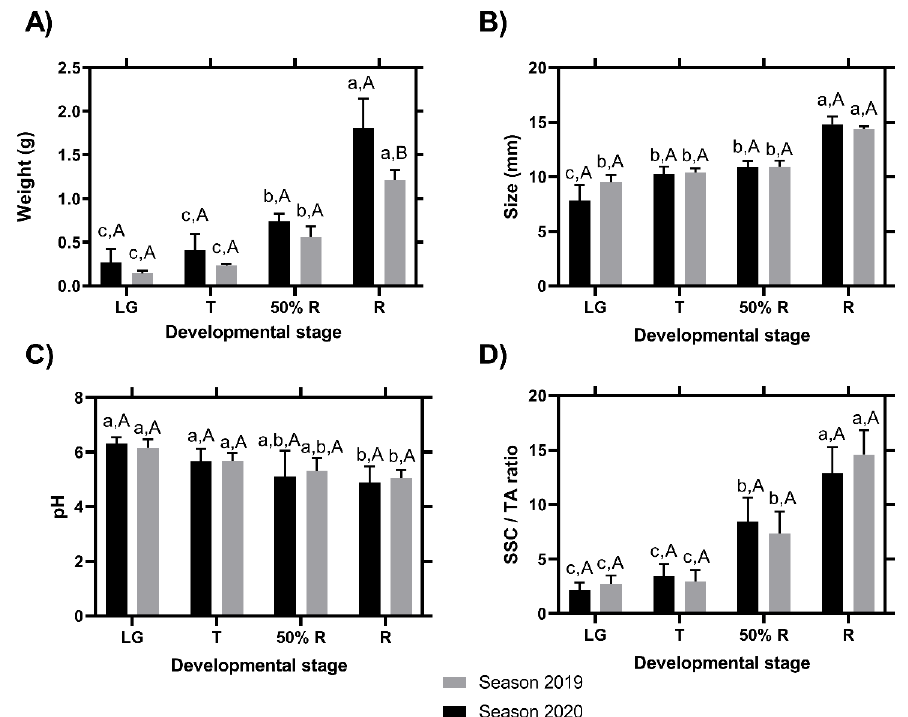
Figure 3. Changes in fruit weight ( A ), size ( B ), pH ( C ), and SSC/TA ratio ( D ) during fruit develop- ment and ripening of the blackberry ( Rubus ulmifolius Schott) fruit in two different seasons. Different capital letters indicate significant differences between the four development and ripening stages. Different lowercase letters indicate significant differences in each season (2019 and 2020) over four development and ripening stages. Differences between means ± standard errors (SE) were determined by ANOVA and the LSD test ( p < 0.05).